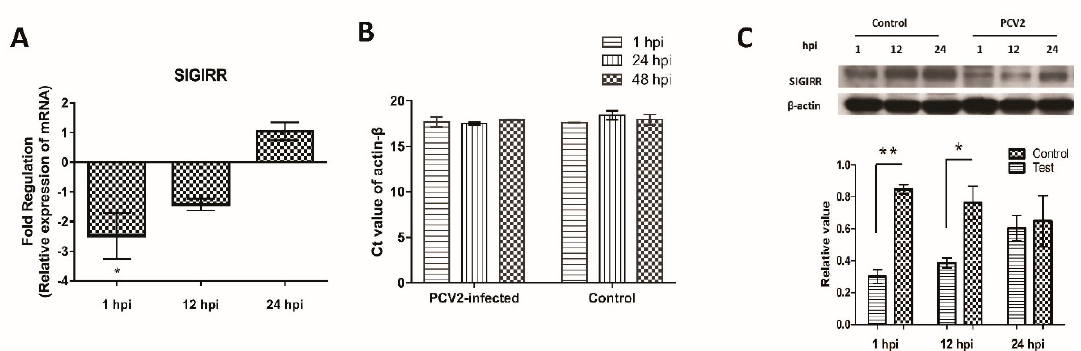
Figure 4. Downregulation of single-immunoglobulin interleukin-1 related receptor (SIGIRR) in PAMs after PCV2 infection. The expression of SIGIRR in PAMs after PCV2 infection were examined using real-time qPCR. The expression of SIGIRR mRNA was normalized to actin- β and presented as fold change relative to the control ( A ). The Ct value of actin- β in PCV2-infected and control groups ( B ). The expression of SIGIRR in protein level was detected by Western blot ( C ). Densitometric analysis was performed to quantify the ratio of SIGGIR to actin- β . Results are mean ± SE of three independent experiments. * represents p < 0.05, ** represents p < 0.01.